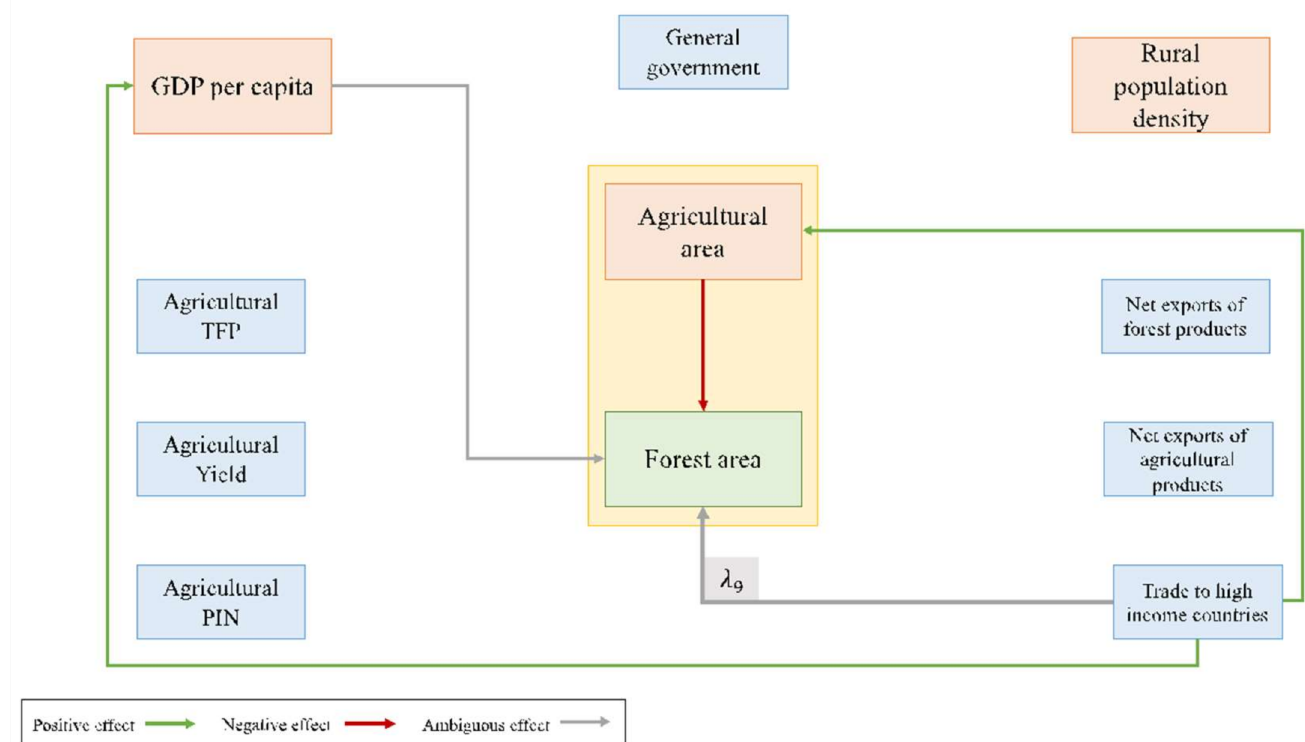
Figure A10. Estimating indirect effects of “Trade to high”